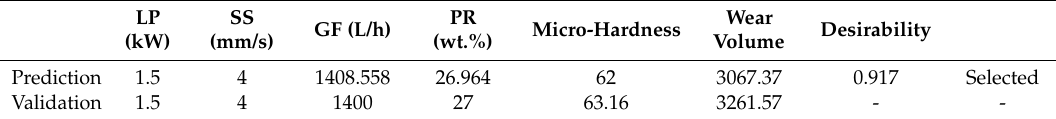
Table 8. Optimization result and parameter selection of the validation